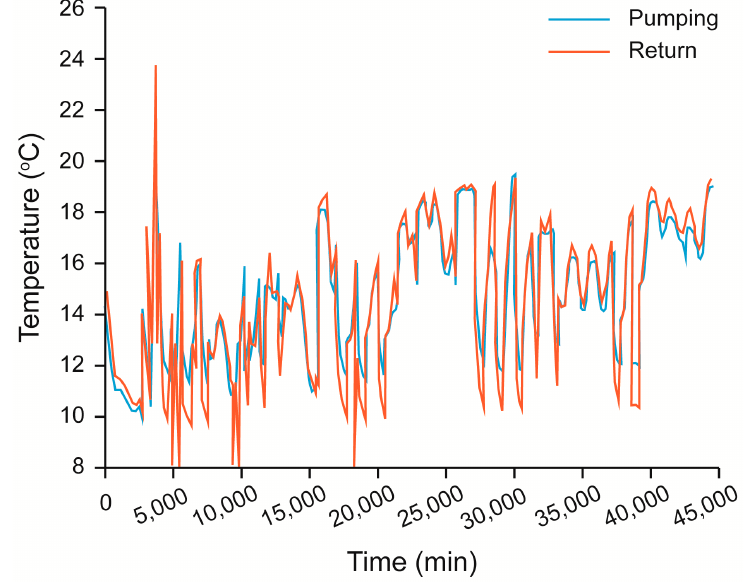
Figure 3. GWHPs Operation schedule and temperature of groundwater.